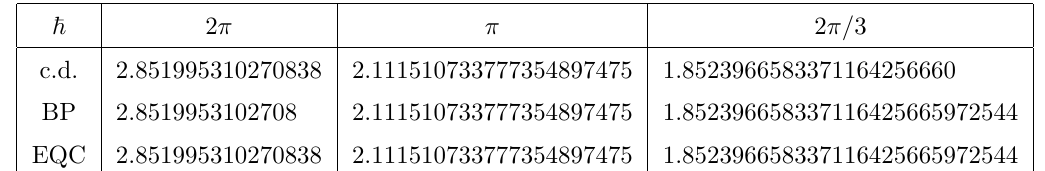
Table 2 . Real part of the (cid:12)rst resonance for local F 0 with log (cid:24) F values of ~ .